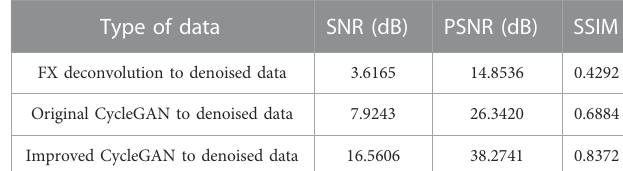
TABLE 1 Comparison of denoising effects on the model seismic data.